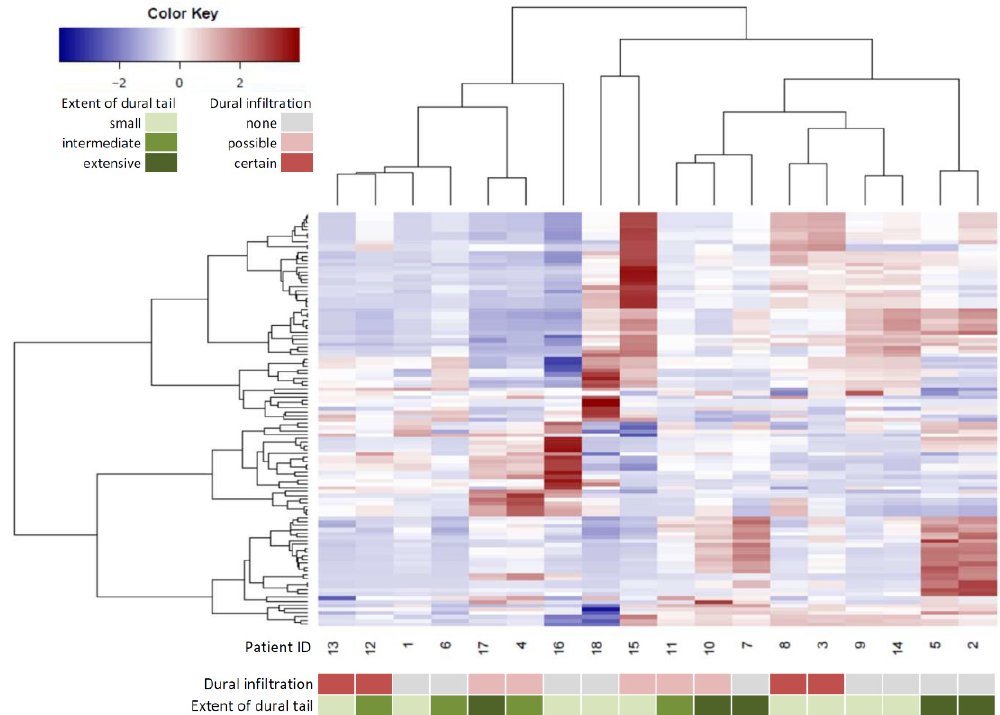
Figure 3. Hierarchical clustering of patients (horizontal axis) according to radiomic features (vertical axis) of the dural tail. The color key of the heat map represents standardized values according to the z-score. Annotation bars represent histologically assessed dural infiltration with tumor cells and the extension of the dural tail.